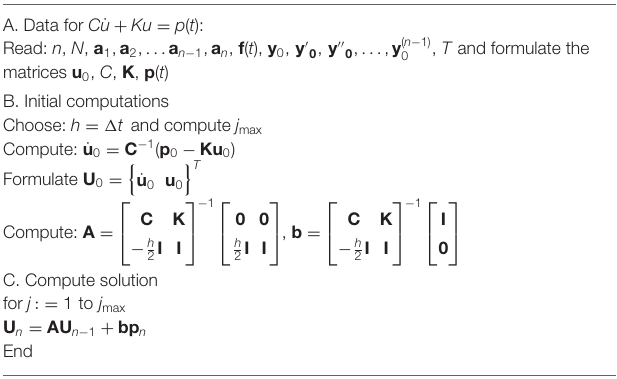
TABLE 1 | Algorithm for the numerical solution of the linear equations n -th order ODEs in the interval [0, T ]. u Ku p ( t ): A. Data for C ˙ + = Read: n , N , a 1 , a 2 , ... a n , a n , f ( t ), y 0 , y ′ 0 , y ′′ 0 , ... , y ( n − 1) 0 , T and formulate the − 1 matrices u 0 , C , K , p ( t